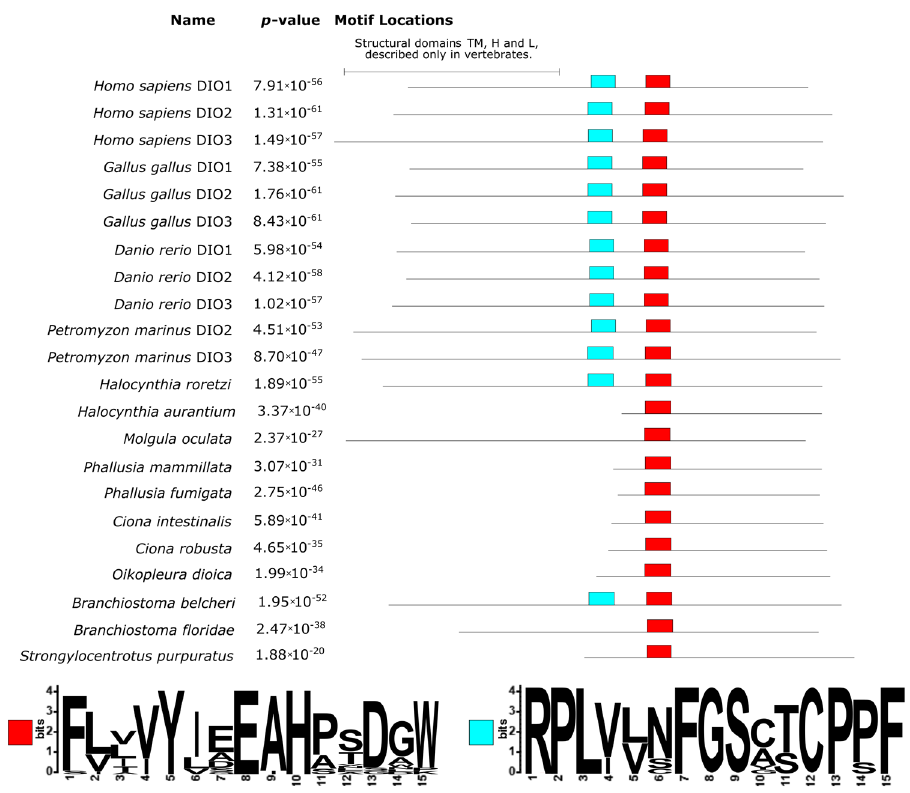
Figure 5. Conserved domain locations and SeqLogo as inferred by the MEME suite on the DIO protein sequences. The proteins were aligned to highlight the occurrence and positioning of the homologous conserved domains, the positions of the boxes reflect the actual positions in the alignment (see Supple- mentary Materials Figure S3). The ubiquitous red box domain corresponds to the dimerization domain, whereas the light blue box is the catalytic globular domain G as described by Orozco et al. (2012)